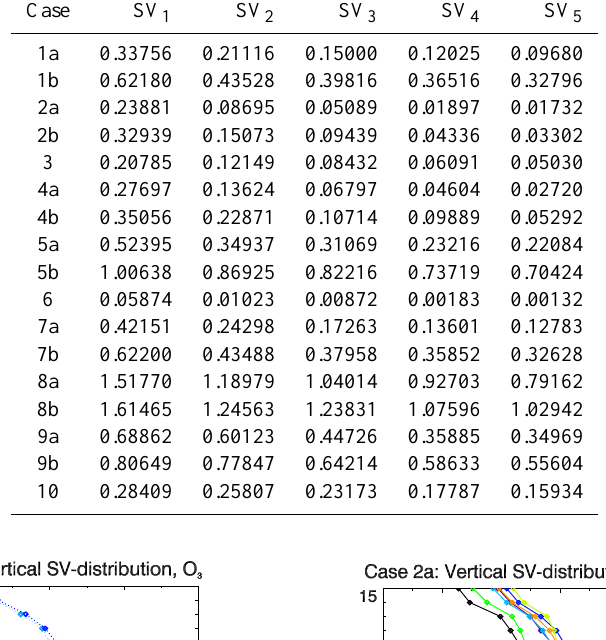
Table 3. Five largest singular values (SV) with respect to initial value uncertainties for all 17 case studies. Case numbers are denoted according to Table 1.